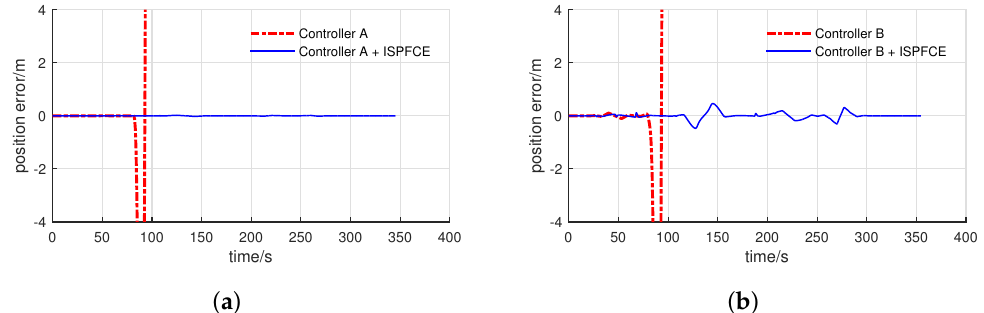
Figure 24. Path tracking errors: ( a ) Controller A and ( b ) Controller